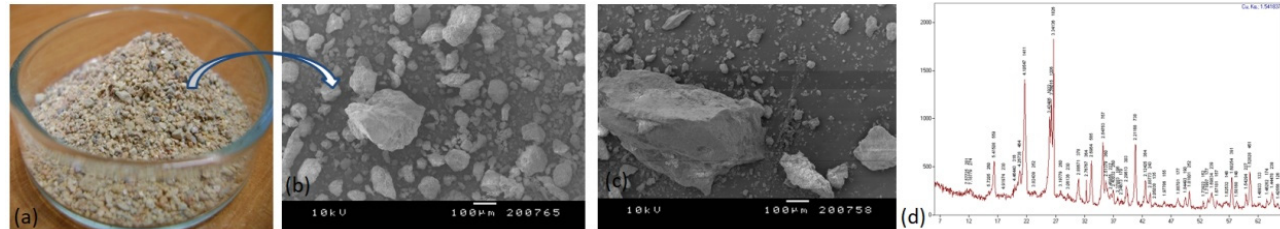
Figure 4. The ceramic dust intended for the laboratory tests: ( a ) natural sample, ( b , c ) sample observed in SEM, ( d ) diffractogram of the sample composition.